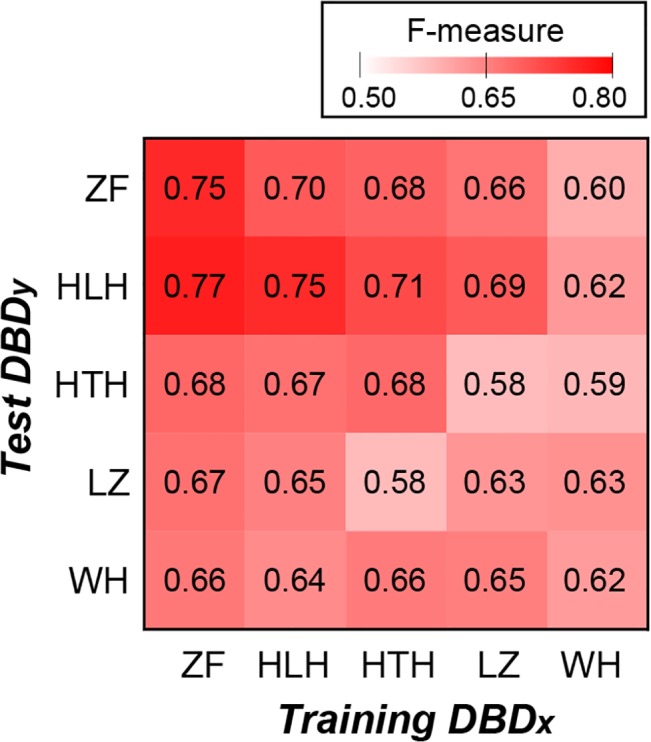
The performances of cross-DBD validations based on predictions using in silico predicted nucleosome occupancy, DNA major groove geometry, and dinucleotide free energy.The five DBD families examined were helix-turn-helix (HTH, 6130 sites), zinc finger (ZF, 8372 sites), leucine zipper (LZ, 3560 sites), winged helix (WH, 1070 sites), and helix-loop-helix (HLH, 2944 sites). Each value in the heat map is the F-measure of a model trained with the dataset of DBDx family member binding regions to predict the test dataset consisting of binding regions of TFs with DBDy. The F-measures on the diagonal are obtained by 10-fold cross-validation.